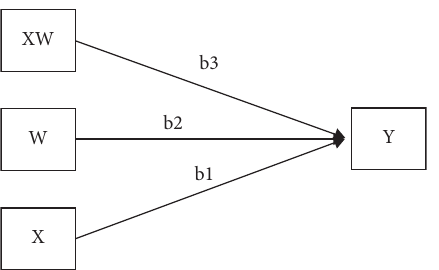
Figure 2: Model of moderation effect in hierarchical regression analysis.